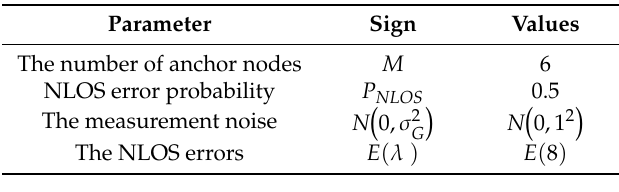
Table 3. Index distribution parameter.